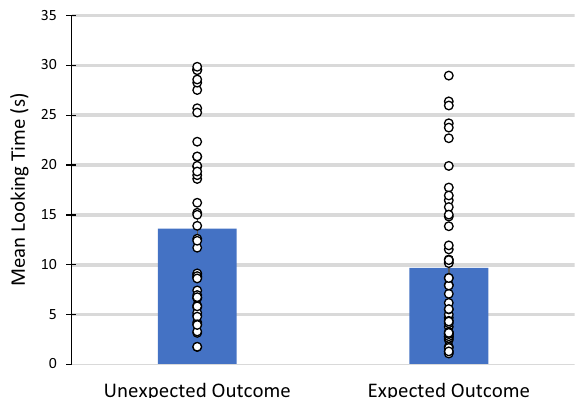
Figure 2. Mean looking time to Unexpected Outcome trial (allies unable to witness conflict) compared with the Expected Outcome trial (allies able to witness conflict) for 9–12 month old infants (within-subjects). Individual data points are depicted. Error bars denote SE of the